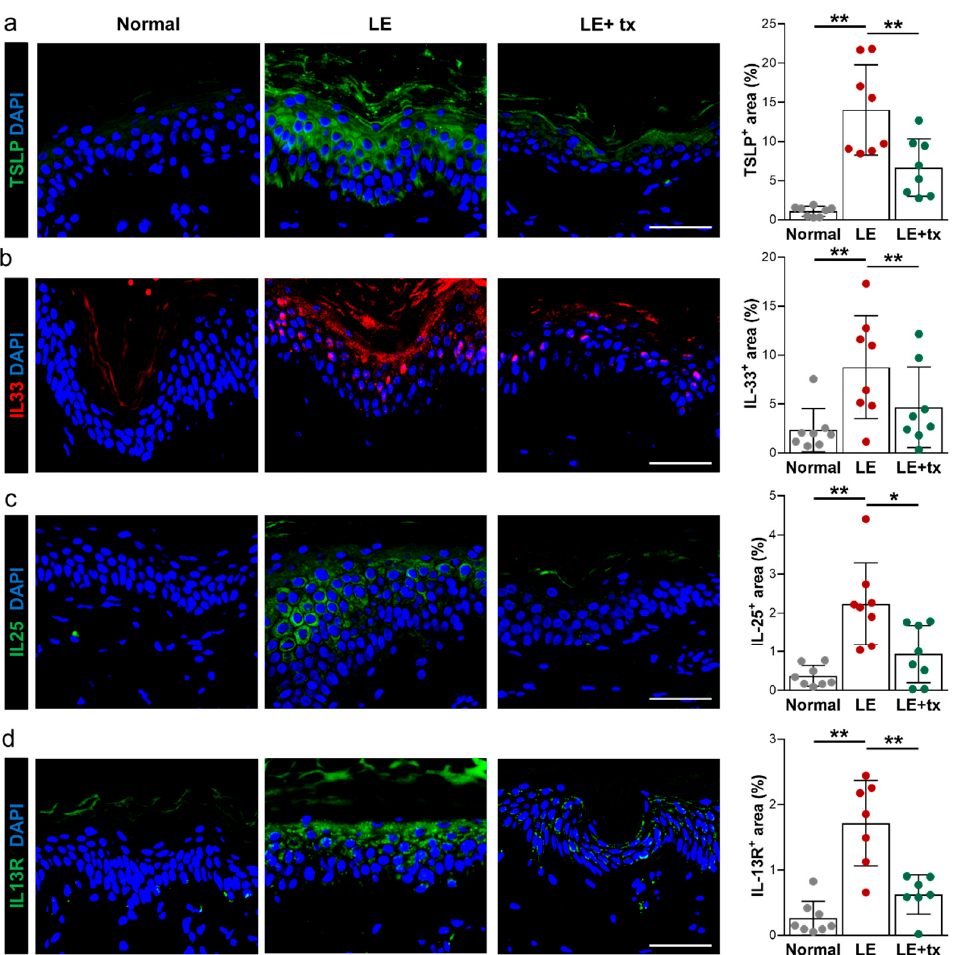
Figure 6. Lymphedema results in increased epidermal expression of Th2 ‐ inducing cytokines. This phenotype is mitigated by treatment with QBX258. ( a ) Representative immunofluorescent staining (left panels) and quantification (right panel) of TSLP (green) in normal, LE, and LE + tx biopsy specimens. ( b ) Representative immunofluorescent staining (left panels) and quantification (right panel) of IL33 (red) in normal, LE, and LE + tx biopsy specimens. ( c ) Representative immunofluorescent staining (left panels) and quantification (right panel) of IL25 (green) in normal, LE, and LE + tx biopsy specimens. ( d ) Representative immunofluorescent staining (left panels) and quantification (right panel) of IL13R (green) in normal, LE, and LE + tx biopsy specimens. Scale bar: 100 μ m; * p < 0.05; ** p < 0.01.